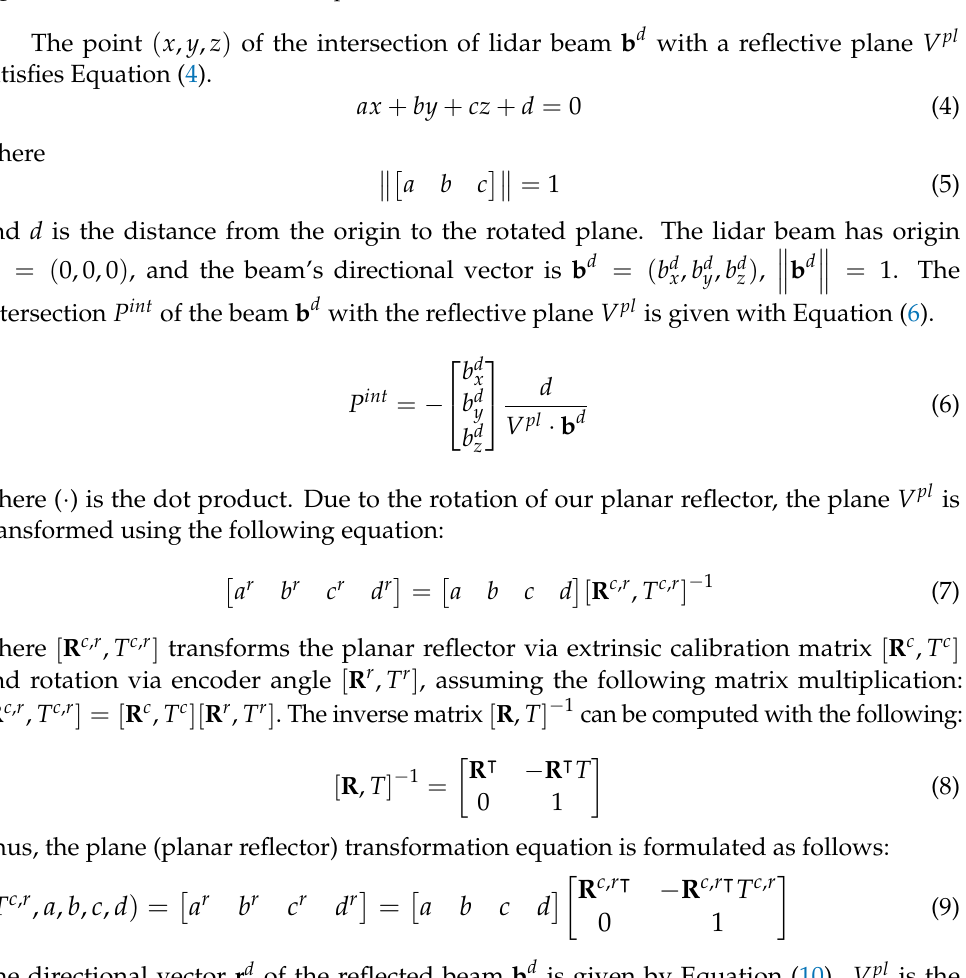
Figure 2. Intersection of a reflective plane and the beam b d